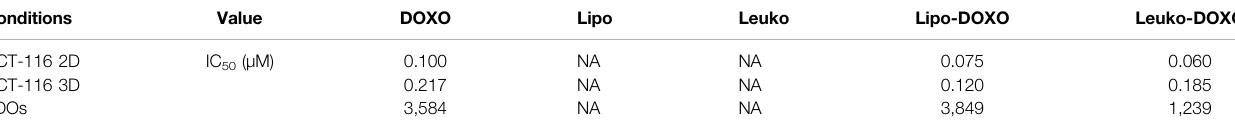
TABLE 1 | Summary of the IC50 values for DOXO, empty Lipo, empty Leuko, Lipo-DOXO and Leuko-DOXO.